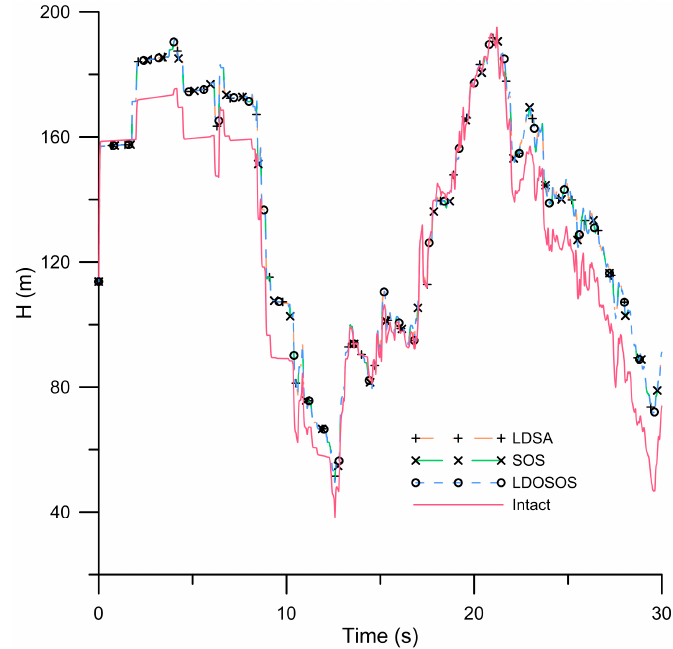
Figure 7. The simulated head distributions at valve for leak detection using various approaches.